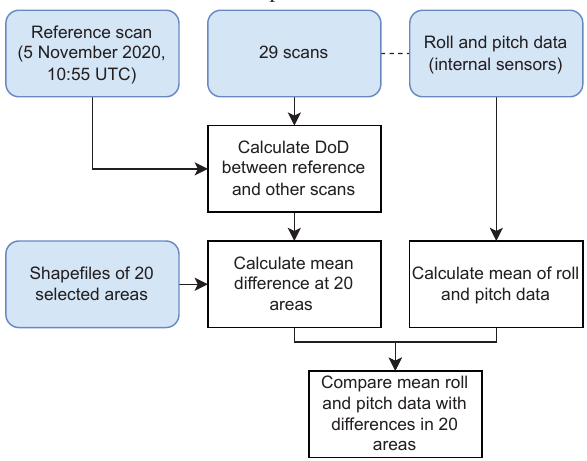
Figure 3. Flowchart with the approach to investigate the stability of the TLS over